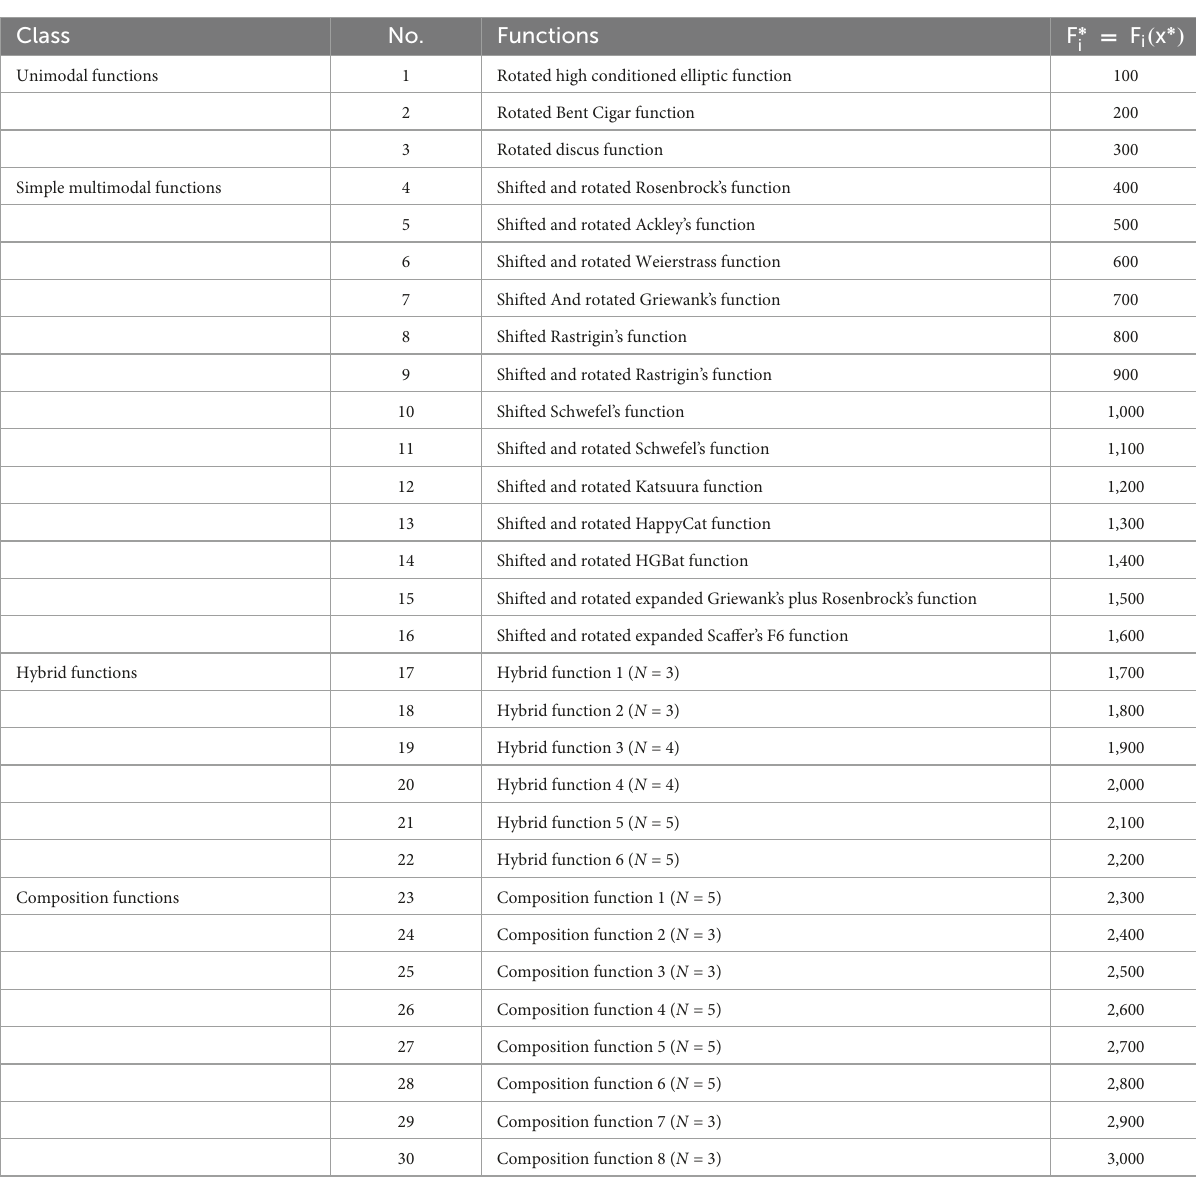
TABLE 1 Description of the 30 benchmark